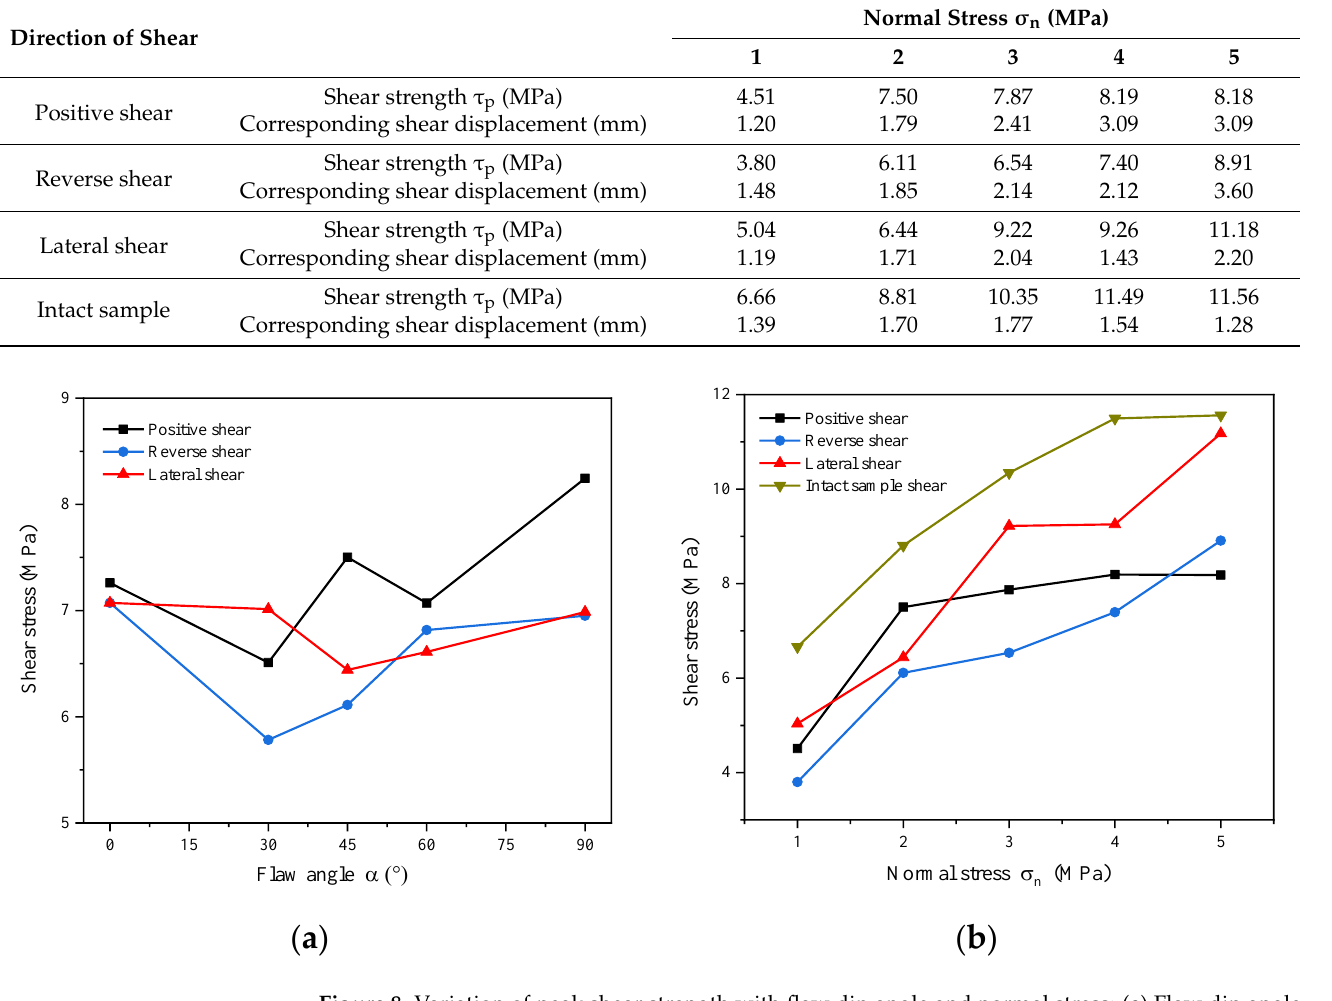
Figure 8. Variation of peak shear strength with flaw dip angle and normal stress: ( a ) Flaw dip angle vs. peak shear strength; ( b ) Normal stress vs. peak shear strength.